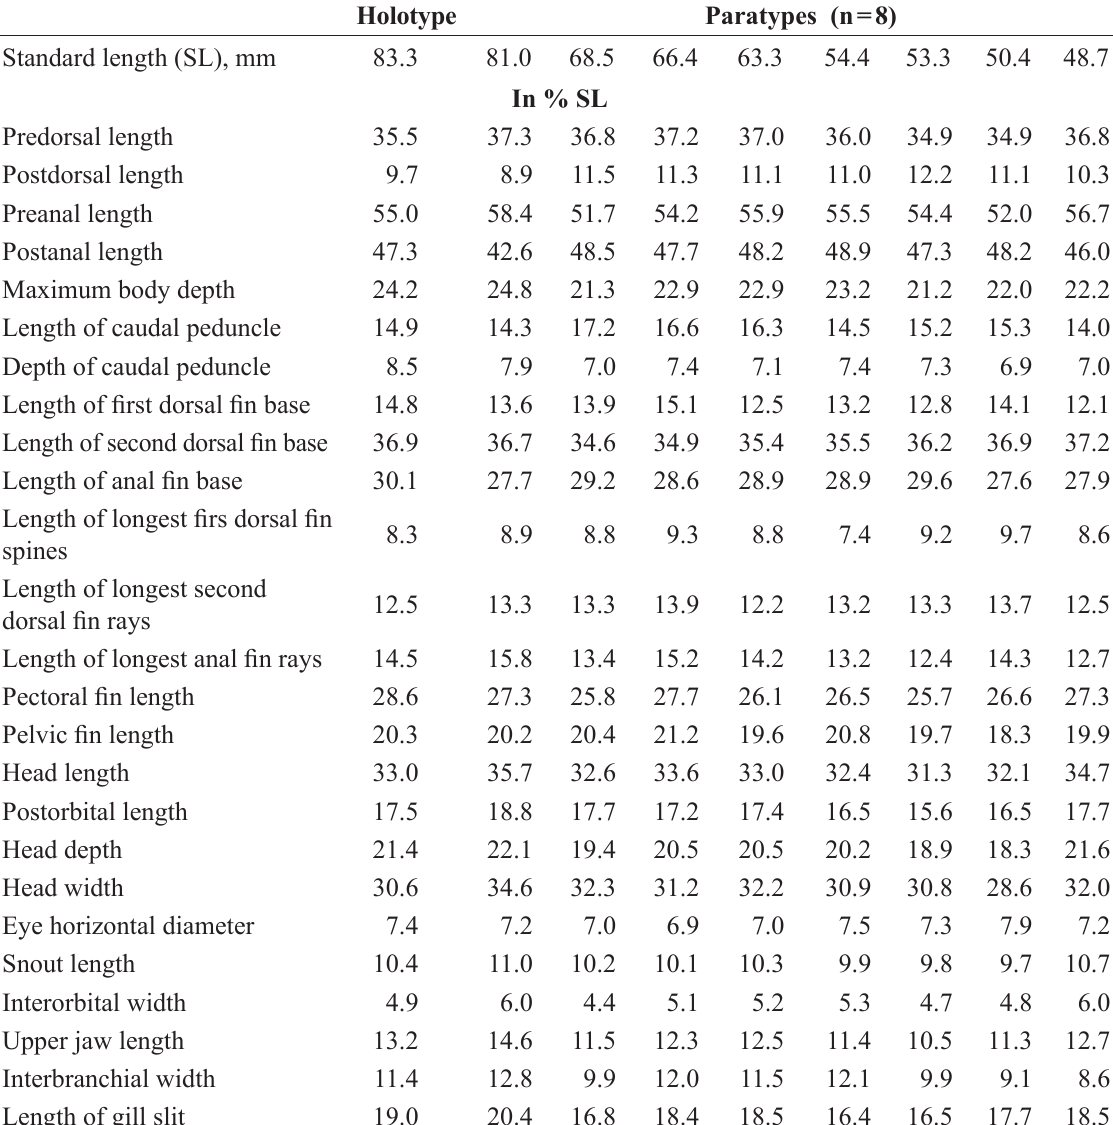
Table 1. Proportional measurements as percentages of standard length of holotype and paratypes of Cottus cyclophthalmus sp. nov. from Krasnaya